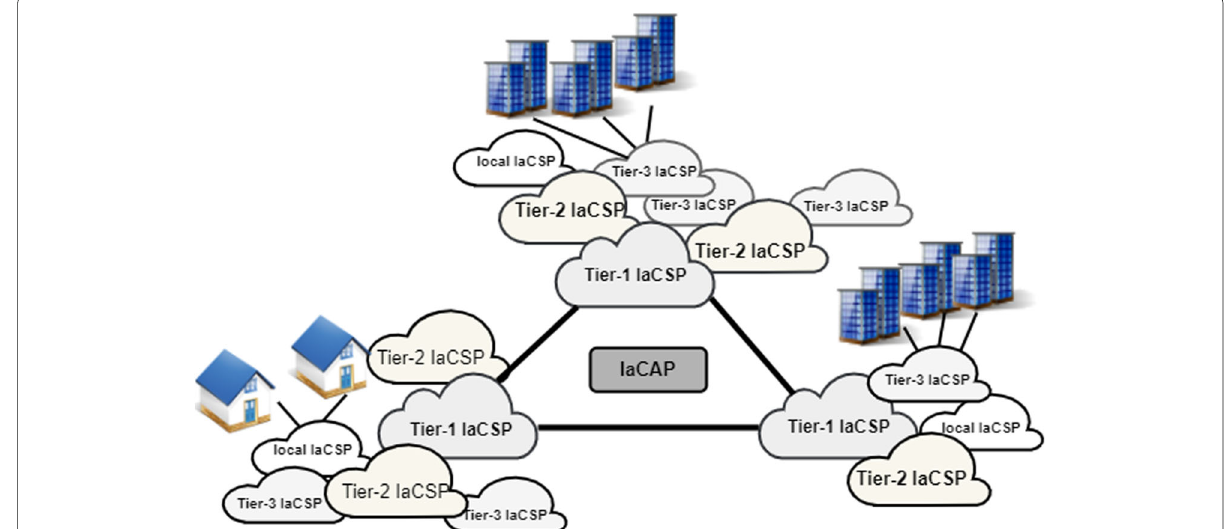
Fig. 2 IaC nodes in a Network of